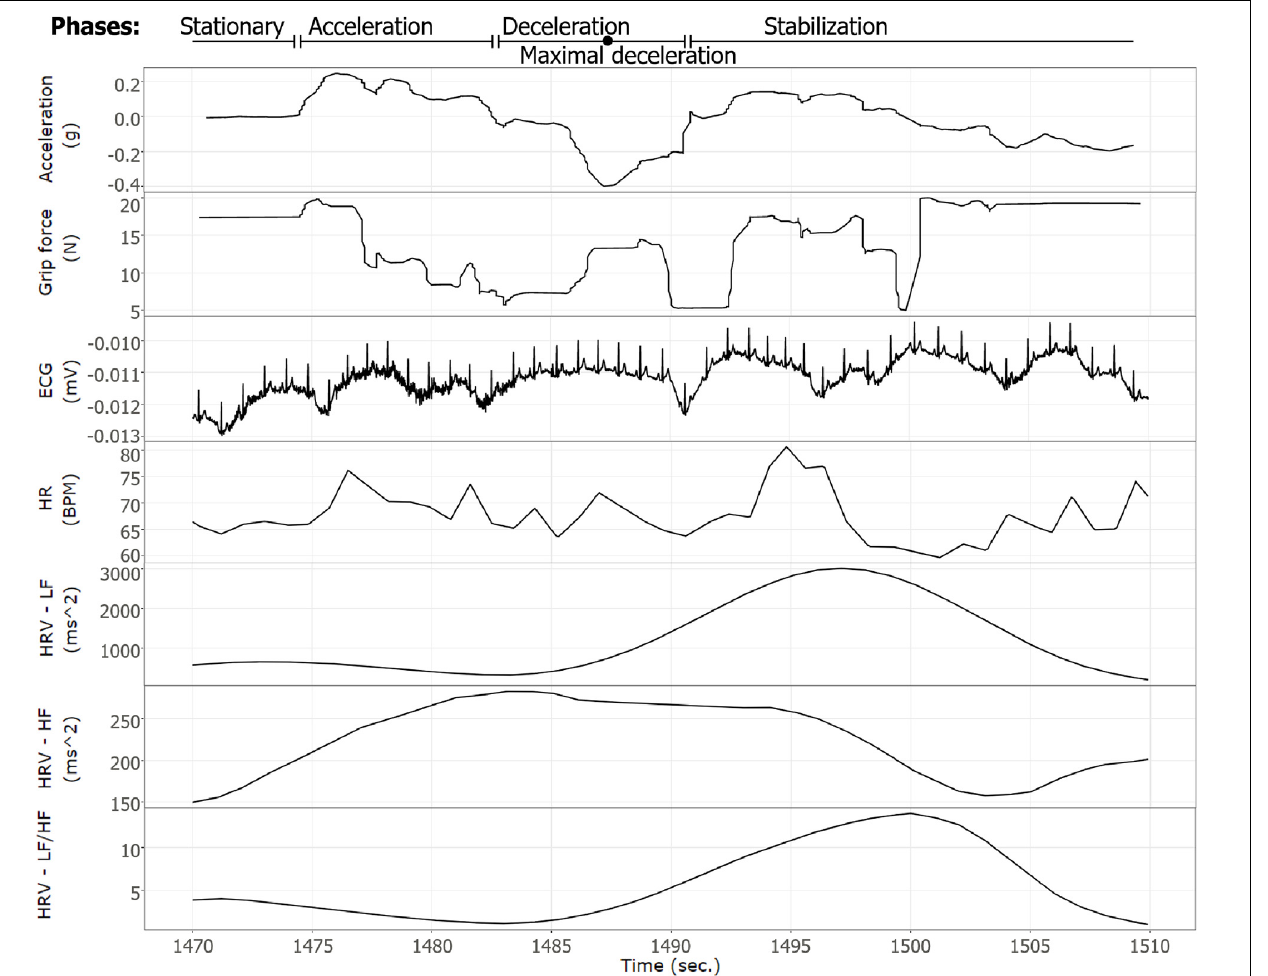
FIGURE 4 | An example of a braking event as expressed by the various measures recorded. A single braking event of participant number 1. The X -axis represents time (s), plots (from top to bottom): acceleration (g), grip force (N), raw ECG signal (mV), HR (BPM), HRV—LF (ms 2 ), HRV—HF (ms 2 ), and HRV—LF/HF